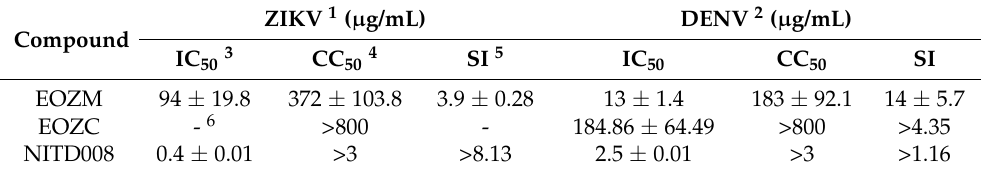
Table 4. Antiviral activity of essential oil from Z. acanthopodium fruits. ZIKV 1 ( µ g/mL) DENV 2 ( µ g/mL) Compound IC 50